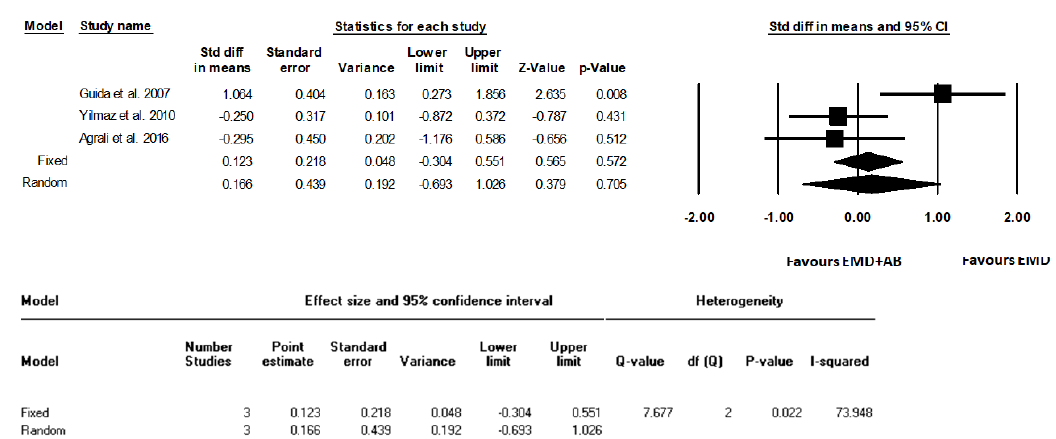
Figure 4. Forest plot from fixed and random effects of meta-analysis evaluating the differences in increase in gum recession (RECinc, mm) after surgical treatment using EMD and autogenous bone or EMD alone (weighted mean difference, 95% CI) with the related heterogeneity analysis.